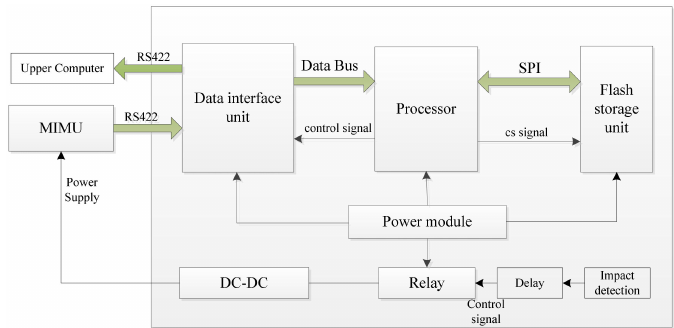
Figure 1. The block diagram of recorder